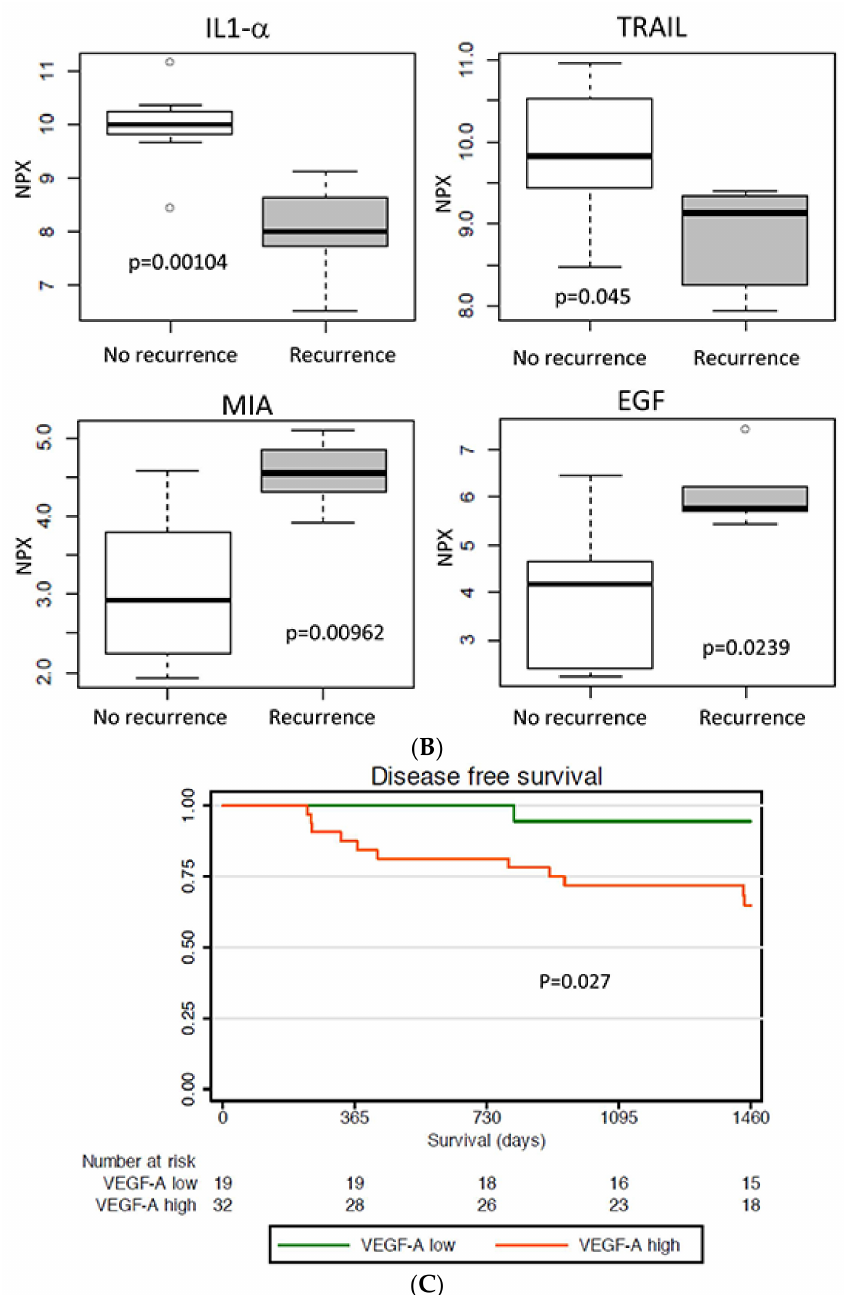
Figure 2. Protein expression in relation to clinical outcome. ( A ) Boxplots presenting the expression of in HPV positive oropharyngeal squamous cell carcinoma (OPSCC) with recurrence vs those with four-year tumor free survival. ( B ) Boxplots presenting the expression of specific proteins in HPV negative OPSCC with recurrence and or death with tumor vs those with four-year tumor free survival. NPX-values in two-log scale. ( C ) Kaplan–Meier curves of disease free survival for 49 patients dichotomized based on tumor VEGFA expression in the validation set. Numbers below the diagram refer to the number of patients at risk at the specific time